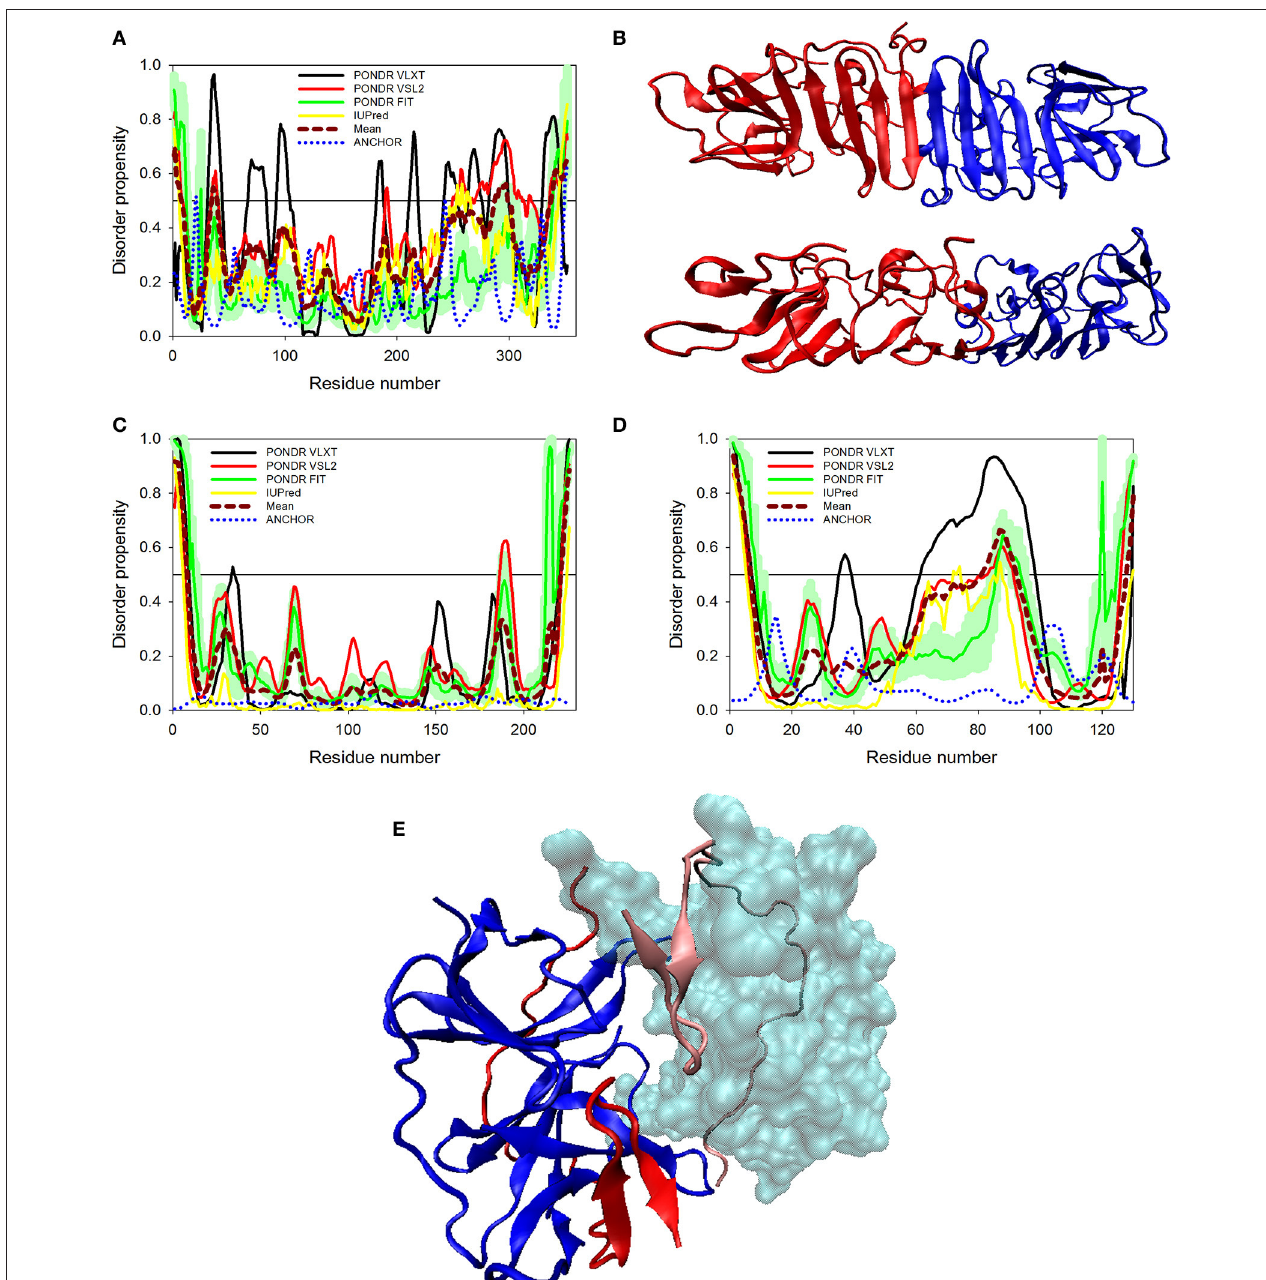
FIGURE 5 | Disorder predispositions of non-structural proteins NS1 (A), NS2A (C) and NS2B (D) . Disorder profiles generated by PONDR ® VLXT, PONDR ® VSL2, PONDR ® FIT, and IUPred are shown by black, red, green, and yellow lines, respectively. Dark red dashed line shows the mean disorder propensity calculated by averaging disorder profiles of individual predictors. Light green shadow around the PONDR ® FIT shows error distribution. Blue dotted lines correspond to the result of the functional disorder analysis using ANCHOR algorithm. (B) 3D-structure of the head-to-head dimer of the NS1 protein, where the β -ladder side (top) and loop arrangement (bottom) are shown. Structure is based on the PDB ID: 5IY3 (Song et al., 2016). Structures of monomers within a dimer are shown as blue and red cartoons. (E) 3D-structure of a hybrid protein containing NS3-binding region of the NS2B protein covalently linked to the protease domain of ZIKV NS3 protein (PDB ID: 5LC0) ( Lei et al., 2016). This hybrid protein is crystallized as a tight dimer. Structures of the NS3-binding region of the NS2B protein are shown as red or pink ribbons in chains (A,B) of this dimer, respectively. Structures of the protease domain of NS3 protein are shown as blue ribbon or cyan surface in chains (A,B) , respectively. For chain (B) , this domain is shown as a transparent surface to simplify visualization of the NS2 chain wrapped around it. Structural representation have been rendered using VMD (Humphrey et al., 1996).